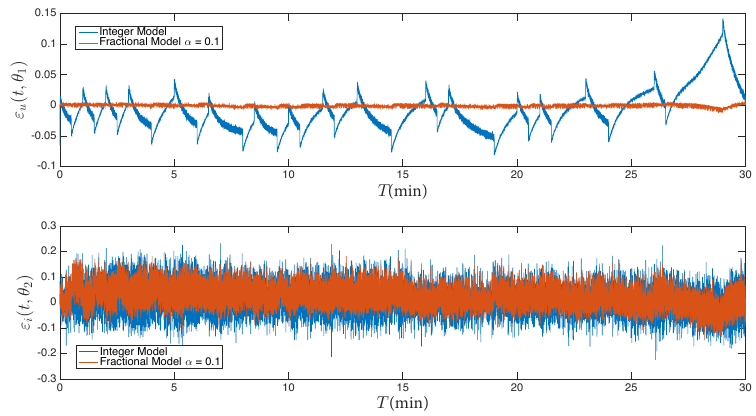
Figure 10. Voltage and current prediction errors ε v ( t , θ 1 ) and ε i ( t , θ 2 ) of optimized fractional models ( α = 0.1) and integer models ( α = 1) in the first 30 min.